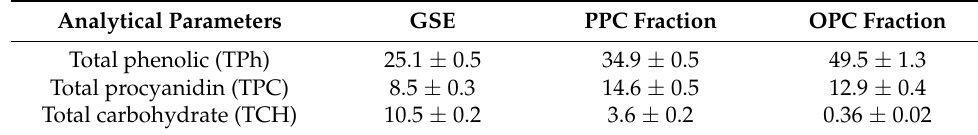
Table 5. Total phenolic, total procyanidin, and total carbohydrate contents of grape seed extract (GSE) and its polymeric procyanidin (PPC), and oligomeric procyanidin (OPC) fractions, expressed in g/100 g of dry mass.